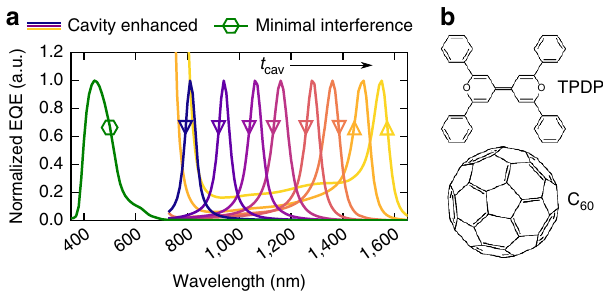
Figure 5 | NIR detectors based on TPDP:C 60 CT absorption. ( a ) Normalized EQE spectra of several tetraphenyl dipyranylidene:fullerene (TPDP:C 60 ) detectors at short circuit. The reference sample ( ) with minimal interference effects has negligible absorption for wavelengths above 700nm. For the cavity-enhanced devices, the resonance wavelength is varied from 810 to 1,550nm by a thickness variation of both transport layers ( r ) — and for selected detectors also by a thickness variation of the TPDP:C 60 blend ( D ). ( b ) Chemical structures of the blend elevated HOMO level 34 which reduces the onset energy of CT